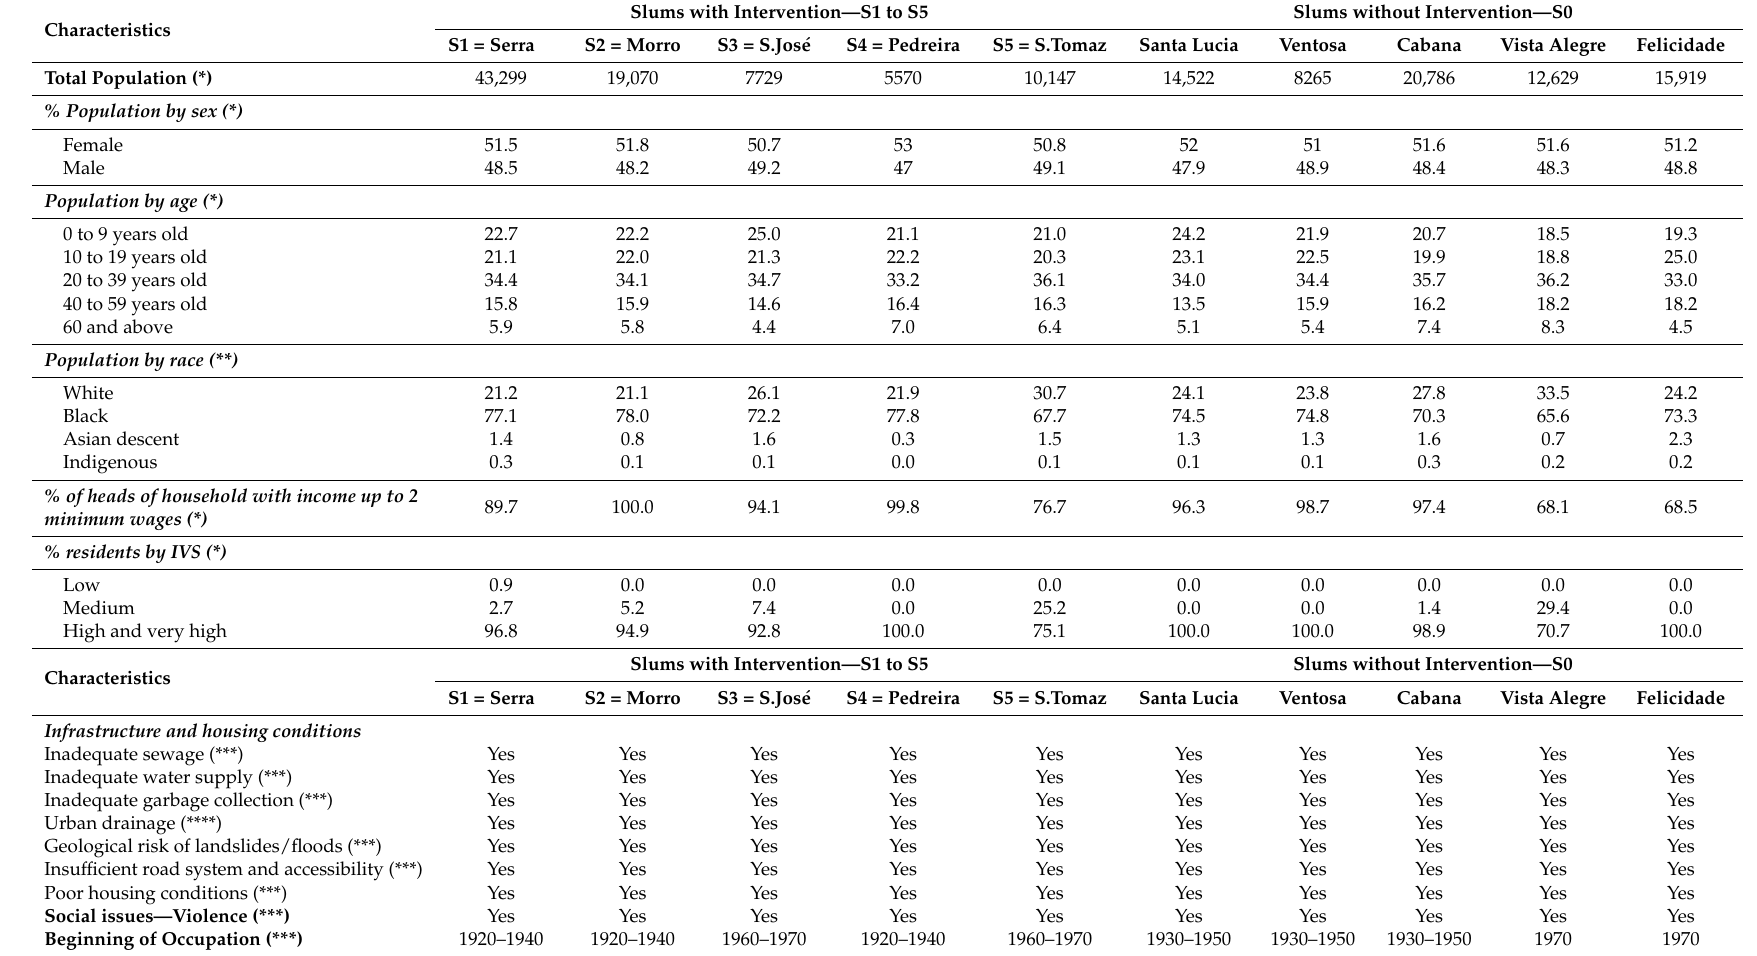
Table 1. Characteristics of the studied slums according to demographic and social